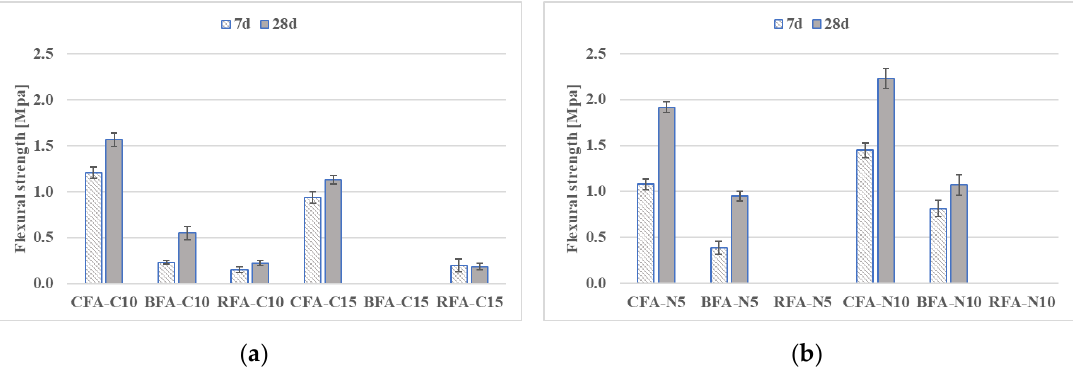
Figure 5. Flexural strength development of mortars with several activators: ( a ) 10% and 15% addition of CaO, and ( b ) 5 M and 10 M of NaOH. Materials 2020 , 13 , 1033